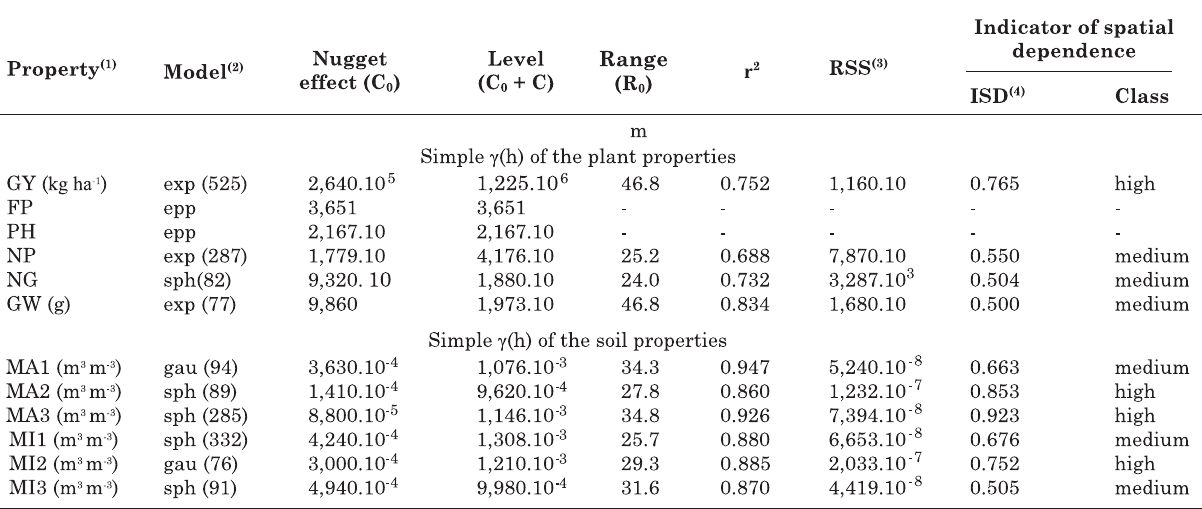
Table 5. Parameters of the simple semivariograms adjusted to some properties of soybean yield and soil (dystroferric Red